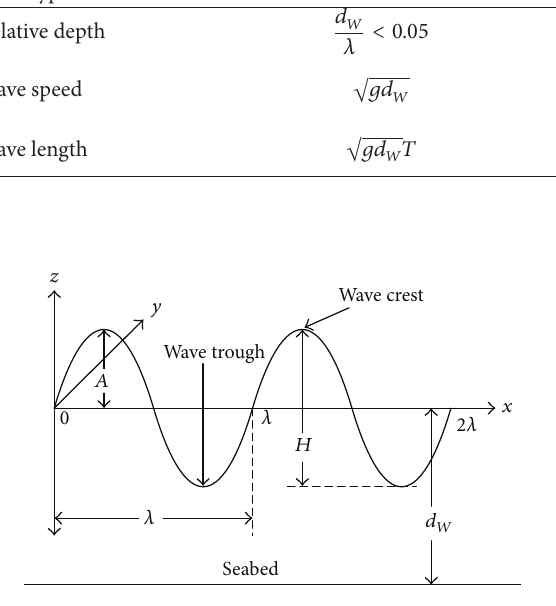
Figure 7: Waveform of a free oceanic